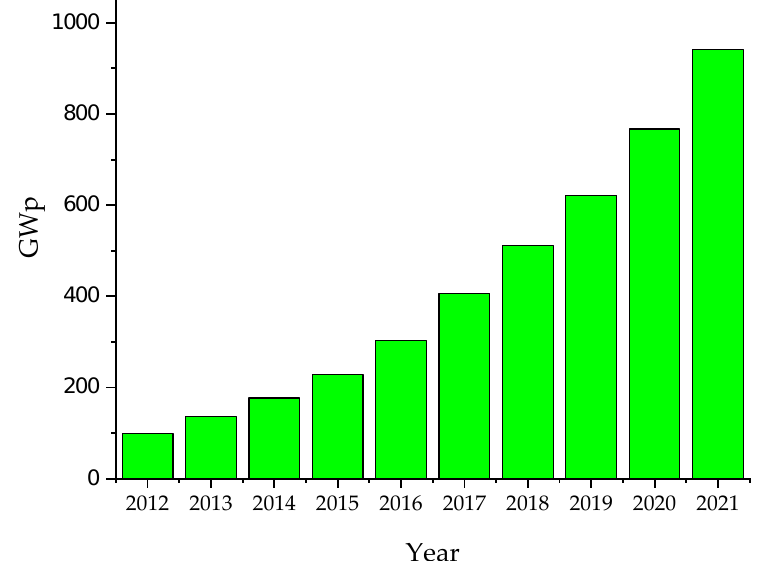
Figure 1. Evolution of PV installations over the past decade [14 – 16].